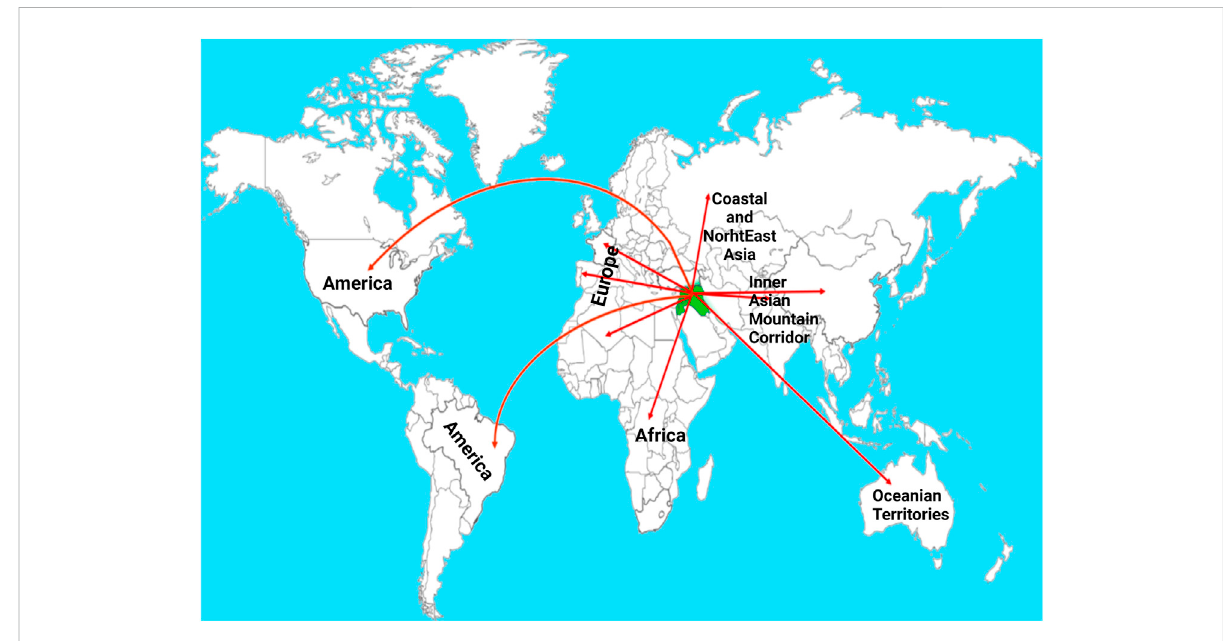
FIGURE 1 Routes showing the migration of wheat from the center of origin-Fertile Crescent-to other continents of the world. The green color indicates Fertile Crescent and the red lines indicate different known routes (Pont et al., 2019). Post-Domestication to Mendel ’ s